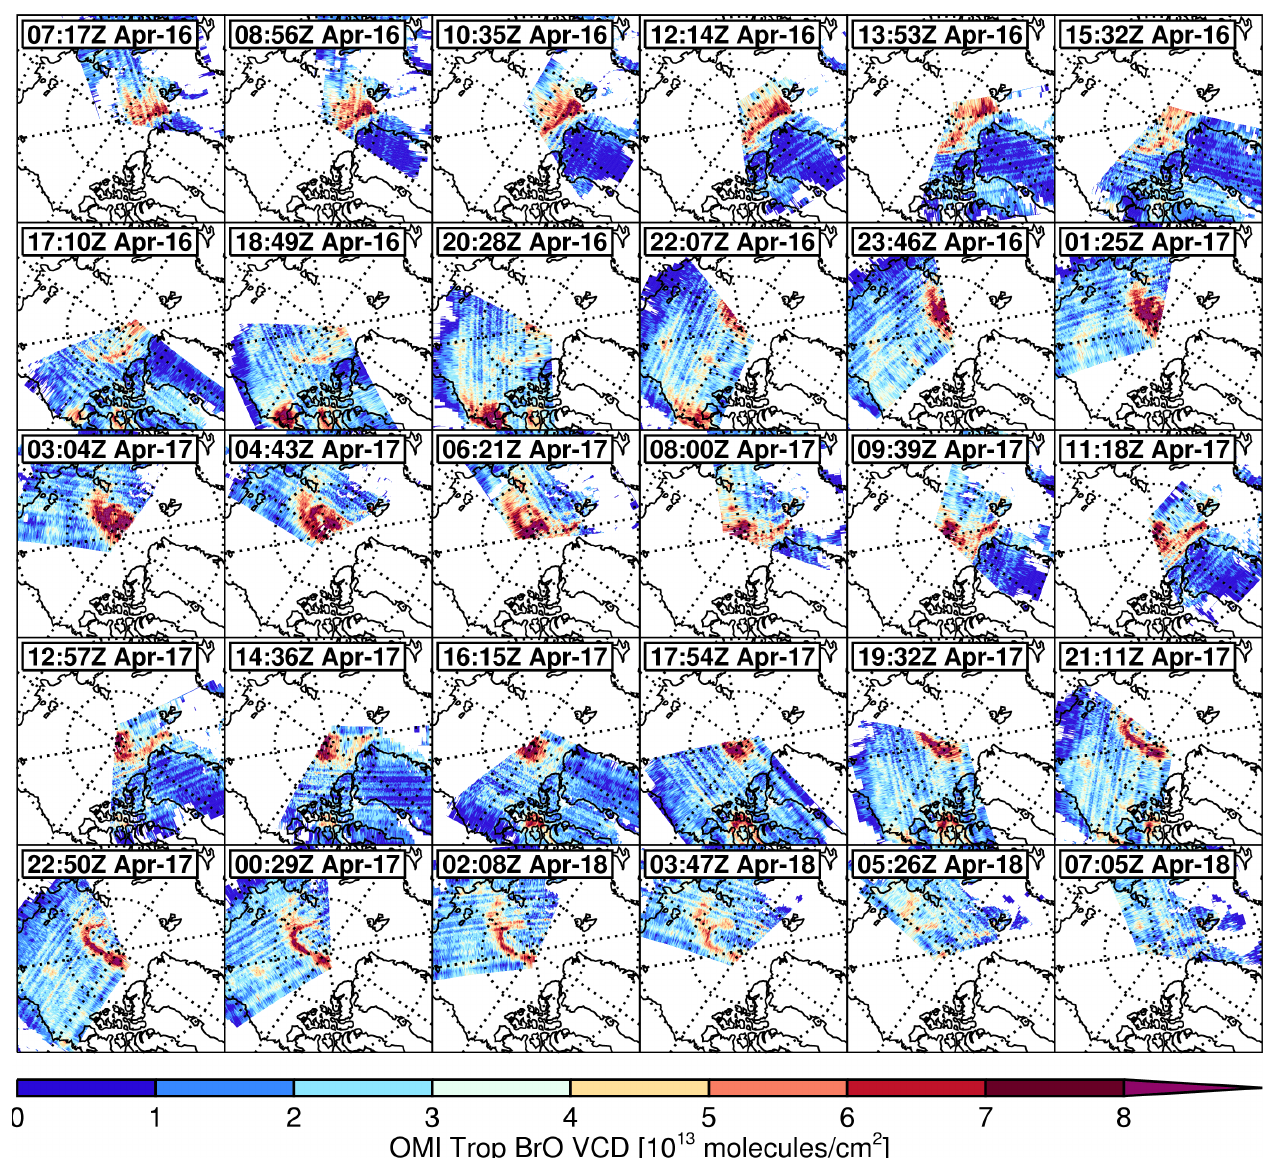
Fig. 11. OMI tropospheric BrO VCD for different orbits (UTC time as indicated) from 16 to 18 April 2008.